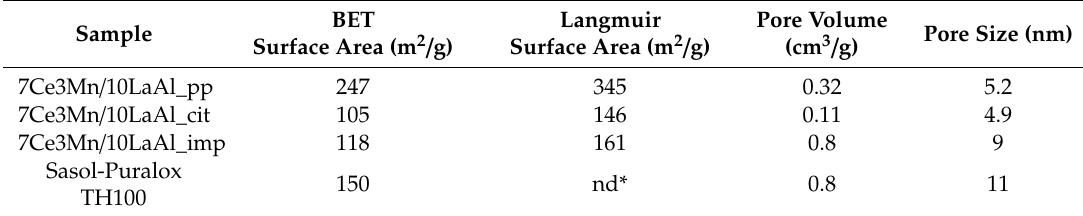
Table 1. Brunauer-Emmett-Teller (BET) and Langmuir surface areas, average pore size, pore volume and pore size of the samples prepared by three